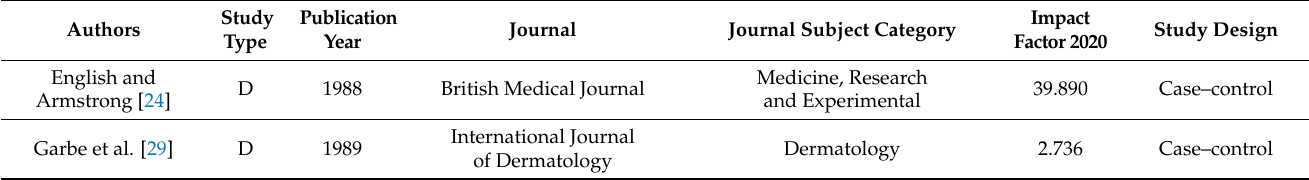
Table A1. Basic characteristics of studies reporting risk prediction models for melanoma. Studies